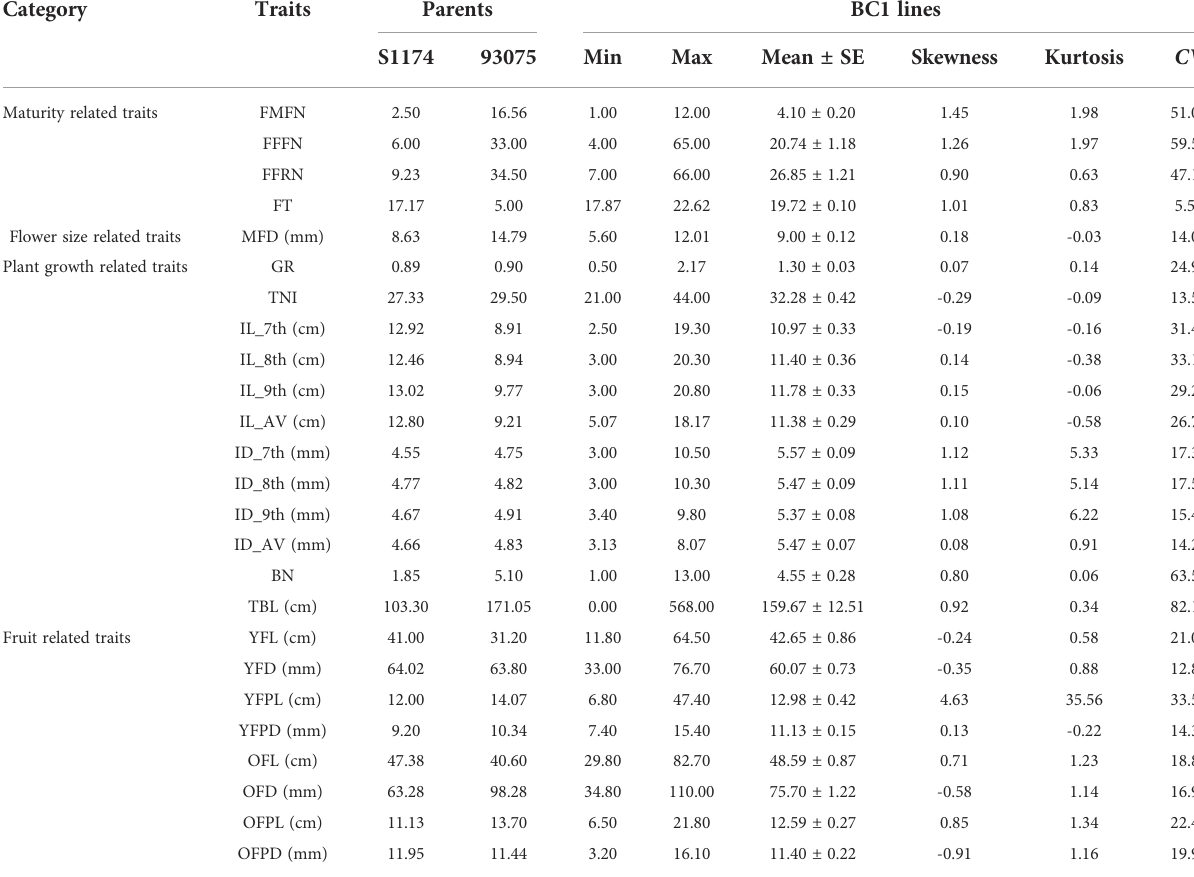
TABLE 1 Basic description of phenotypic data in parental lines and the BC1 population.